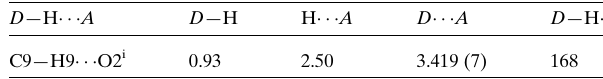
Table 2 Hydrogen-bond geometry (A˚ , (cid:3) ) for B .